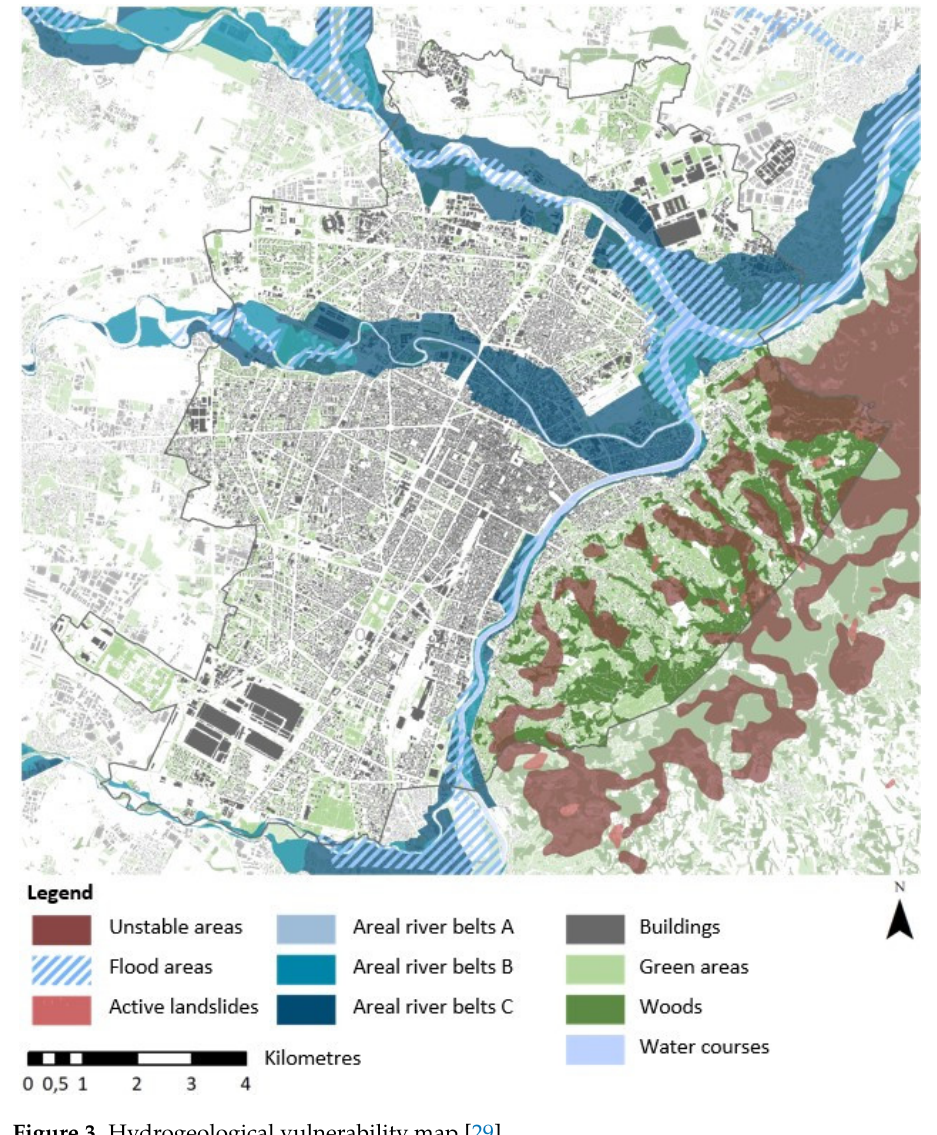
Figure 3. Hydrogeological vulnerability map [29]. Table 3. Landscape Assets of the City of Turin